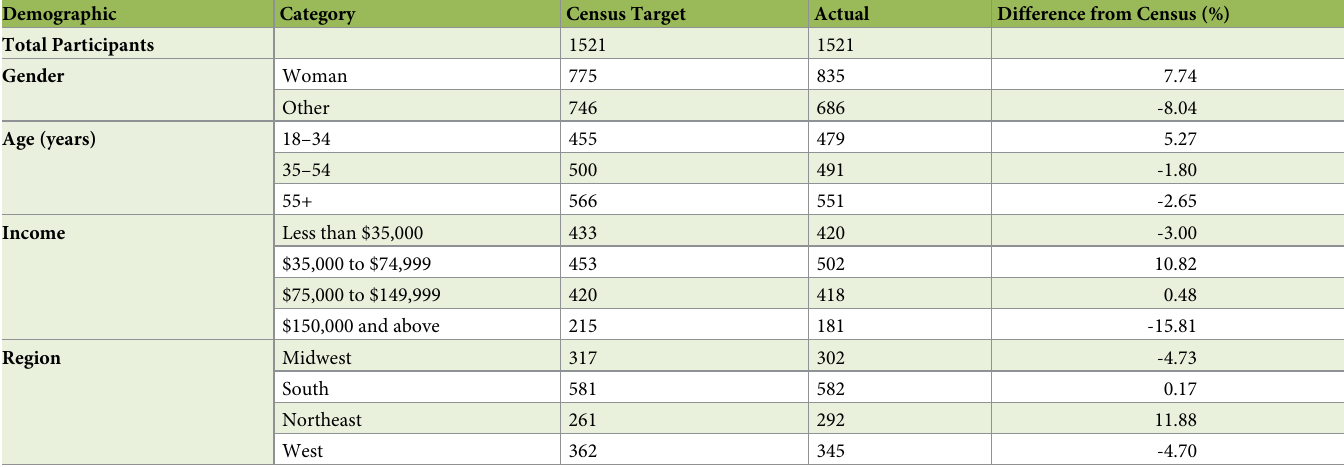
Table 1. Participant demographic targets vs actual